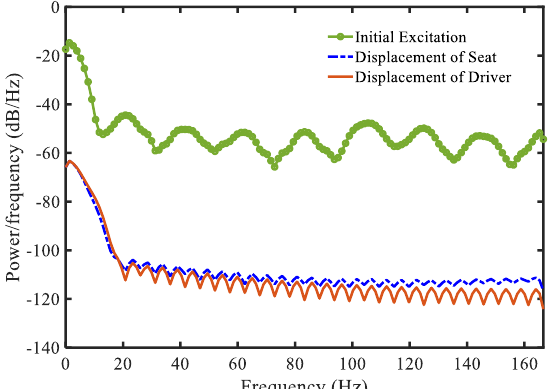
Figure 5. Simulation result of power spectral density of displacements under random step wave road